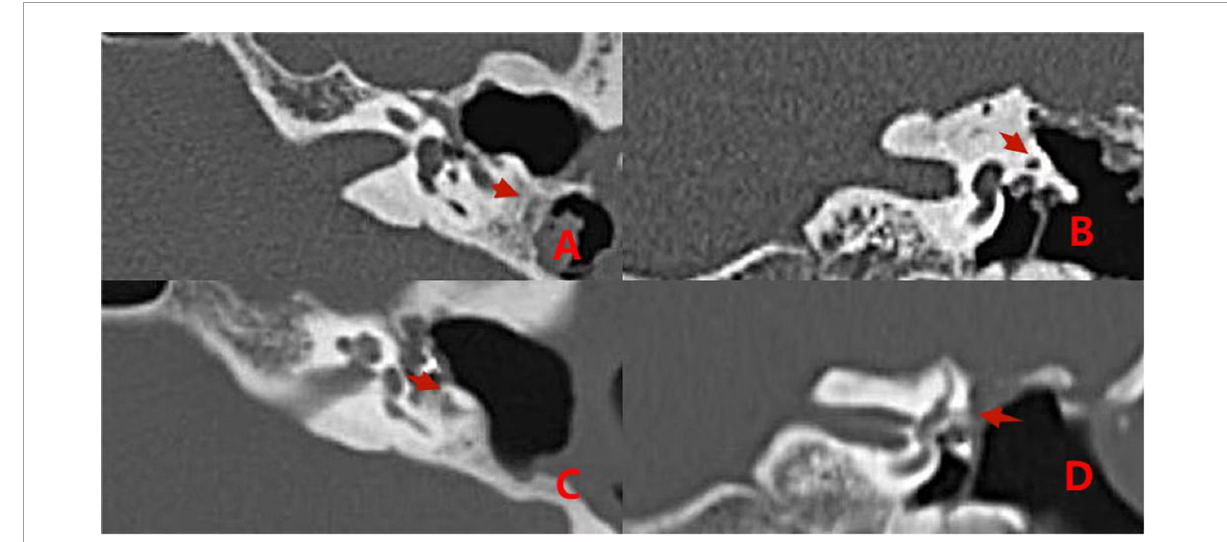
FIGURE6 CT images acquired before and after surgery from a patient with type II labyrinthine fistula undergoing a second surgery. Preoperative (A,B) : The left cholesteatoma is adjacent to the bone resorption with a normal external semicircular canal shape (the red arrows). Postoperative (C,D) : The removal of cholesteatoma, the abnormal shape of the external semicircular canal, and the intraoperative fillers inside and adjacent to it (the red arrows).